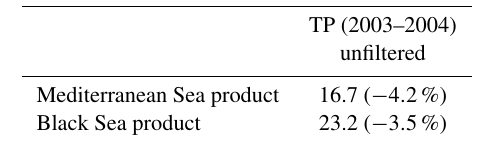
Table 5. Variance of the differences between gridded (L4) DT2018 two-satellite merged regional Mediterranean and Black Sea prod- ucts and independent TP interleaved along-track measurements without filtering over the time period 2003–2004 (cm 2 ). In paren- theses: variance reduction (%) compared to the results obtained with the DT2014